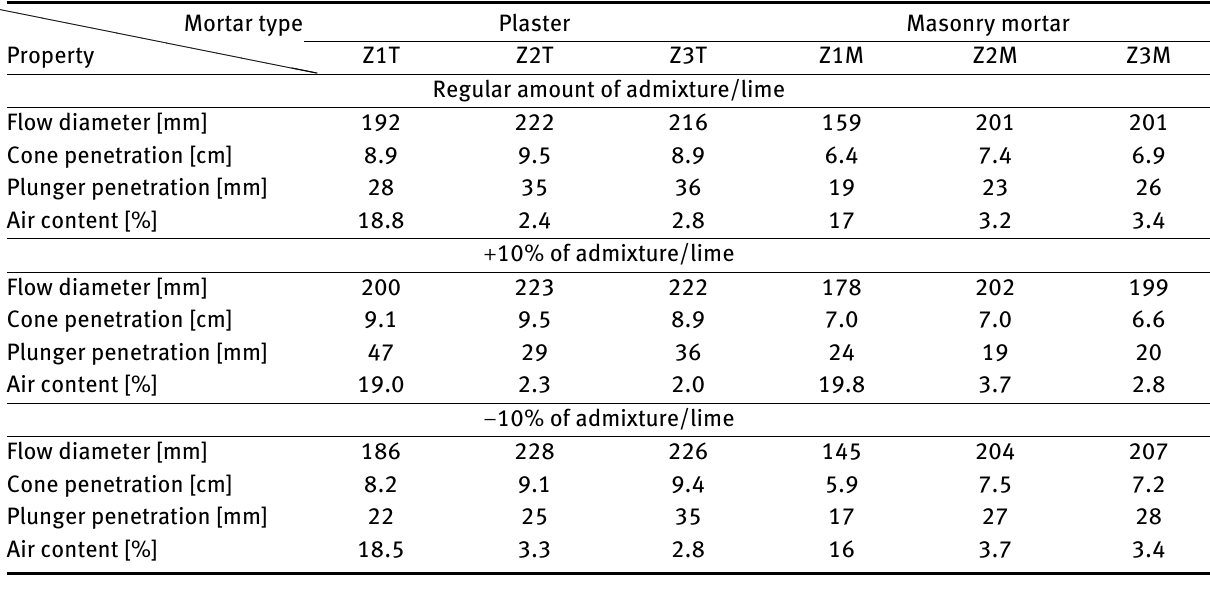
Table 6: Results of the tests of plaster and mortars with 10% changes of admixture/lime content. (cid:96)(cid:96)(cid:96)(cid:96)(cid:96)(cid:96)(cid:96)(cid:96)(cid:96)(cid:96)(cid:96)(cid:96)(cid:96)(cid:96) Property